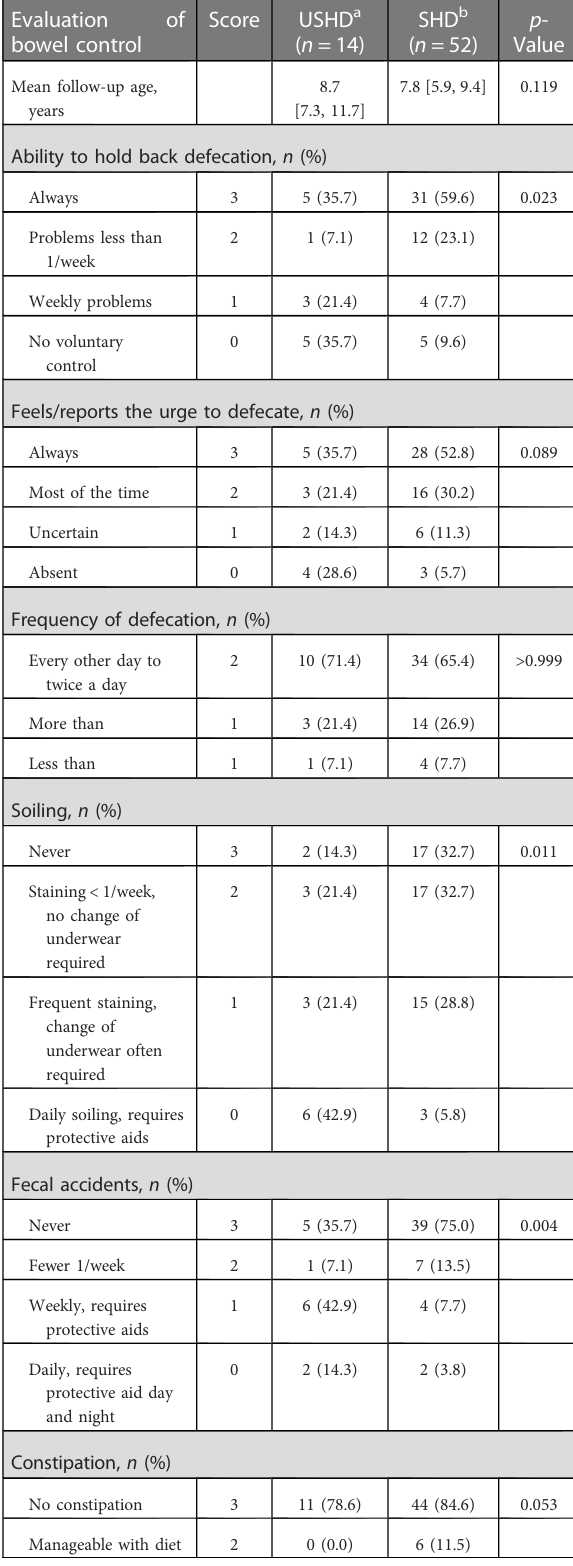
TABLE 2 Patient characteristics.